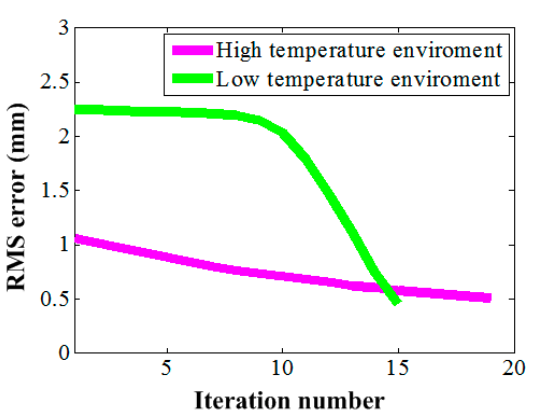
Figure 6. Surface root mean square (RMS) error during adjustment.